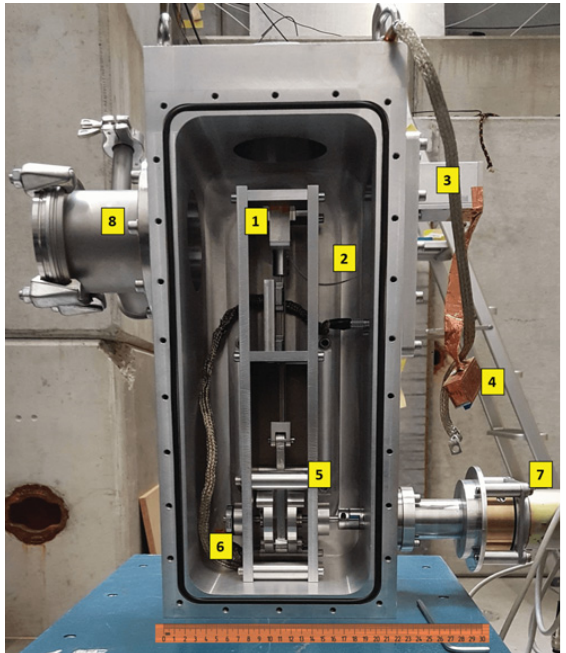
Figure 2. Oscillating UCN Spectrometer (OTUS): 1) detector head; 2) moving connection cable; 3) preamplifier box; 4) connecting cable to the interface module; 5) crankshaft mechanism; 6) driving motor synchronization sensor; 7) DC motor; 8) vacuum flange.